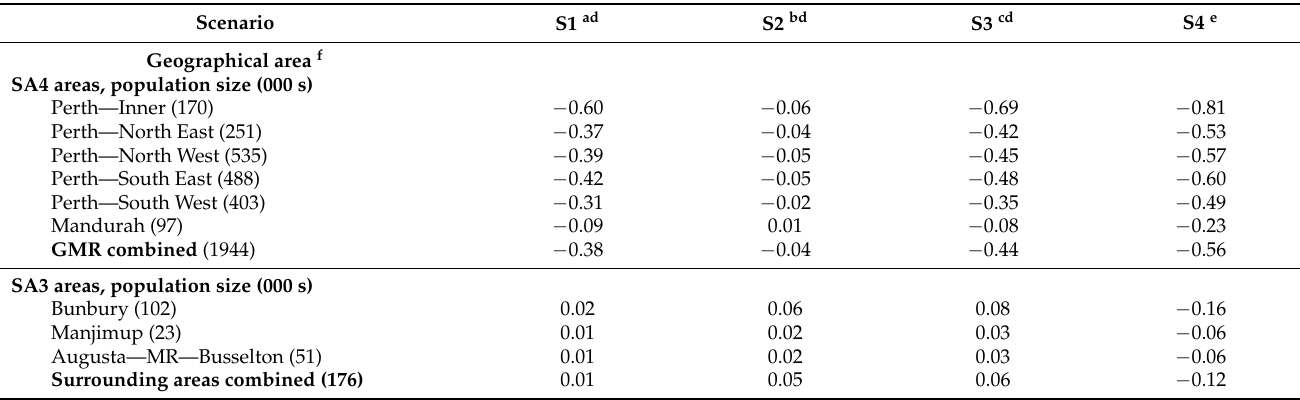
Table 2. Estimated change in PM 2.5 concentration * by area for selected